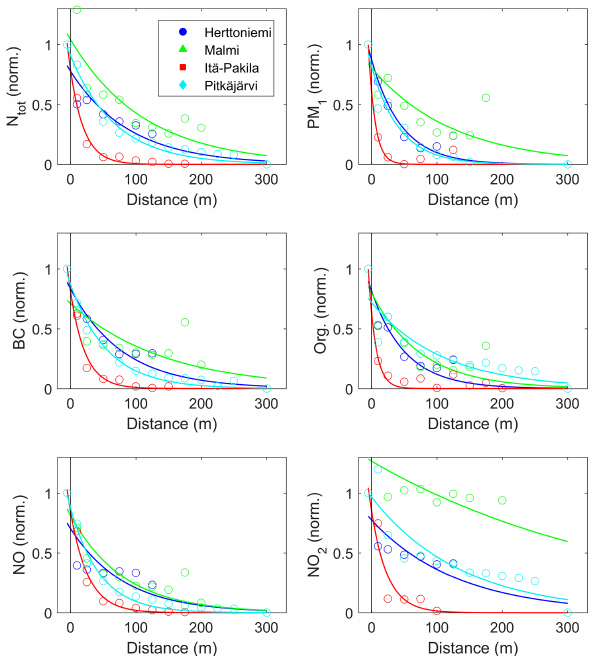
Figure 2. Normalized particle number ( N tot ) and mass concentra- tion (PM 1 ) , BC, and organics concentration, as well as NO and NO 2 concentration, as a function of distance from the highway at four measurement locations shown in the legend. Zero distance refers to the edge of the road, and negative values to driving on the highway. Also shown are the fitted reduction curves. Background values were subtracted from the measured